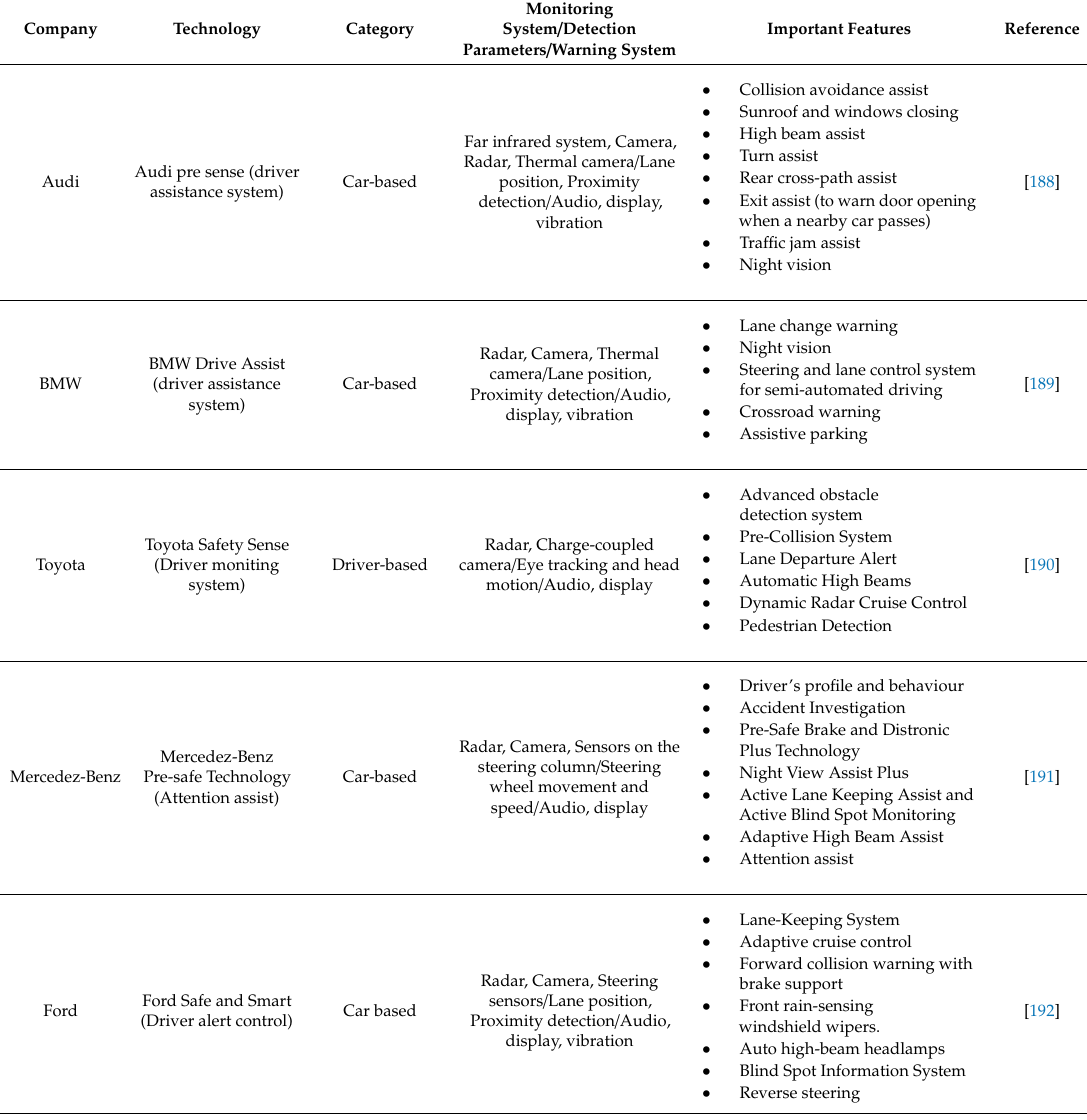
Table 4. A summary of DMAS available in modern